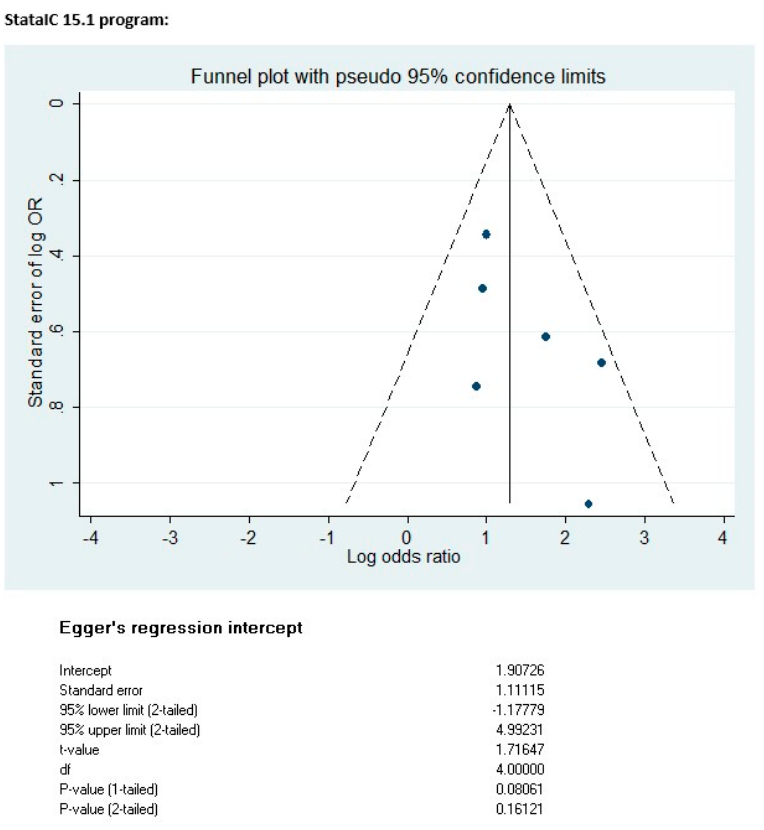
Figure 6. Funnel plot and Egger’s regression test on determining publication